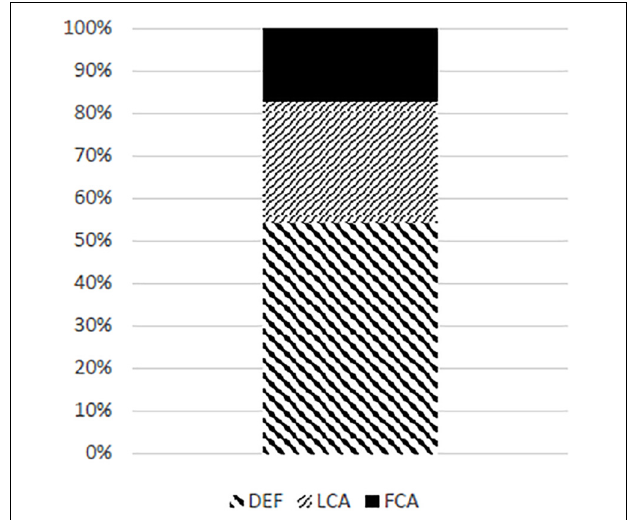
in which they are not suppressed or asymmetrically facilitated by additional factors. The best candidate for such a configuration is one with coordinated subjects involving only plural